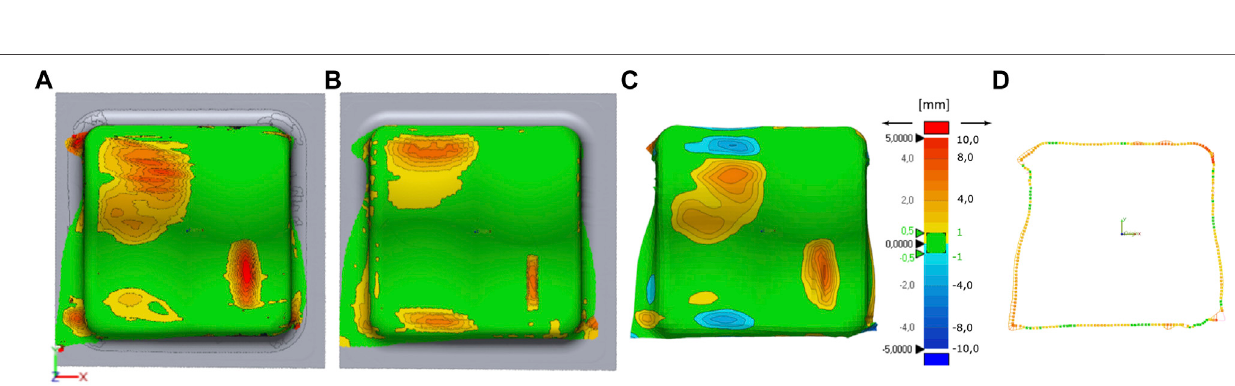
Frontiers in Materials |